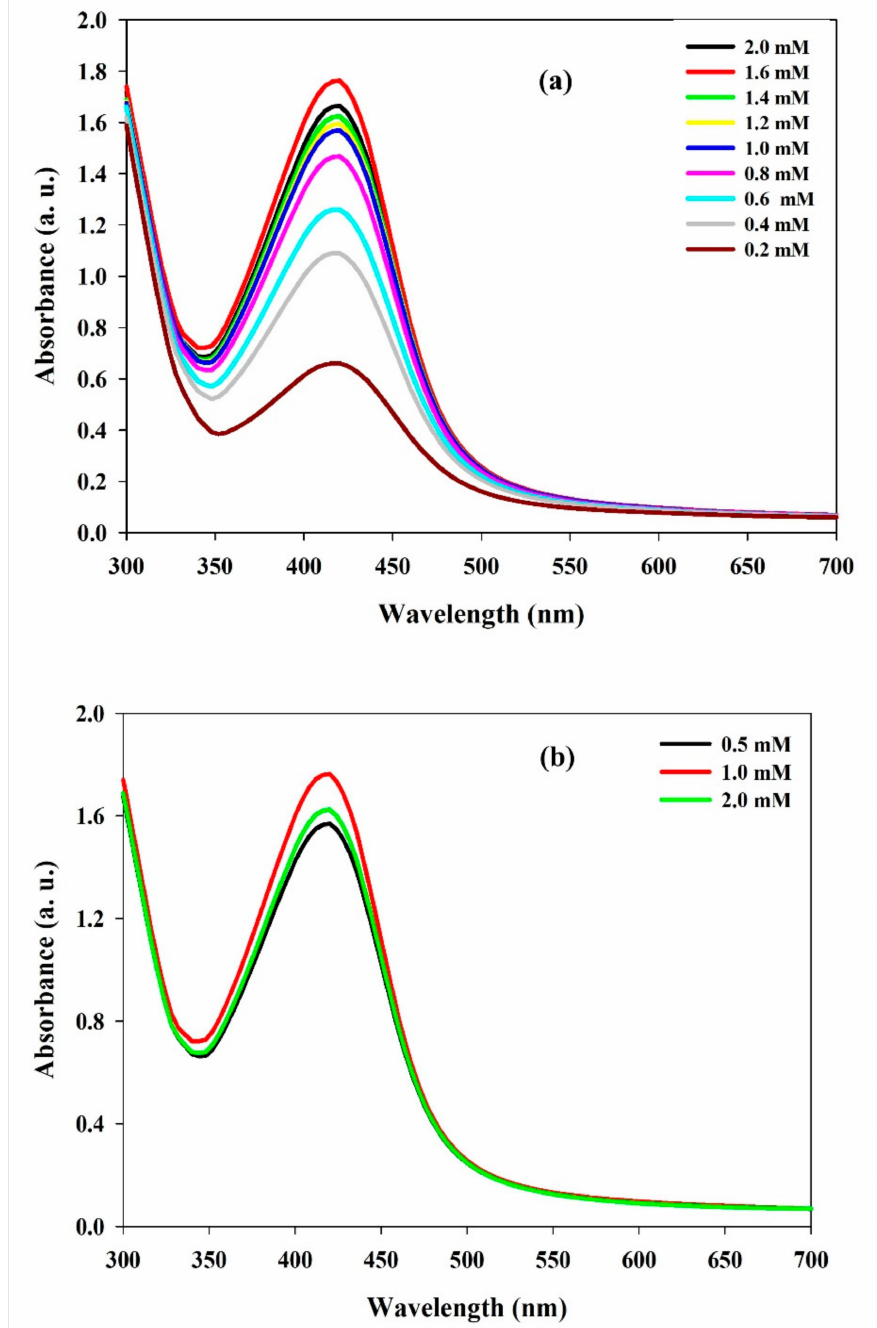
Figure 1. Effects of ( a ) lignosulfonate concentration (0.2 mM to 2.0 mM) and ( b ) silver nitrate concentration (0.5 to 2.0 mM) on LS–Ag NP